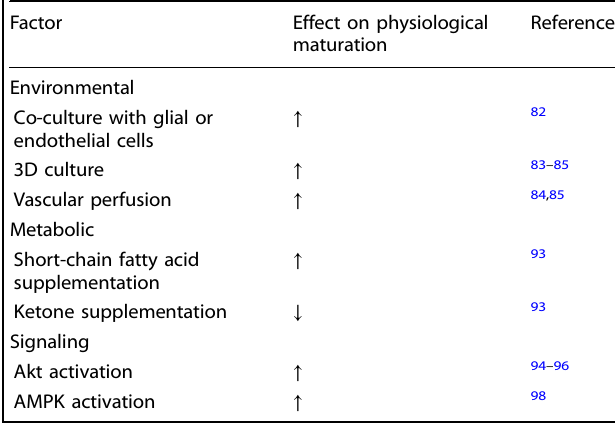
Table 2. Factors in fl uencing neural tissue